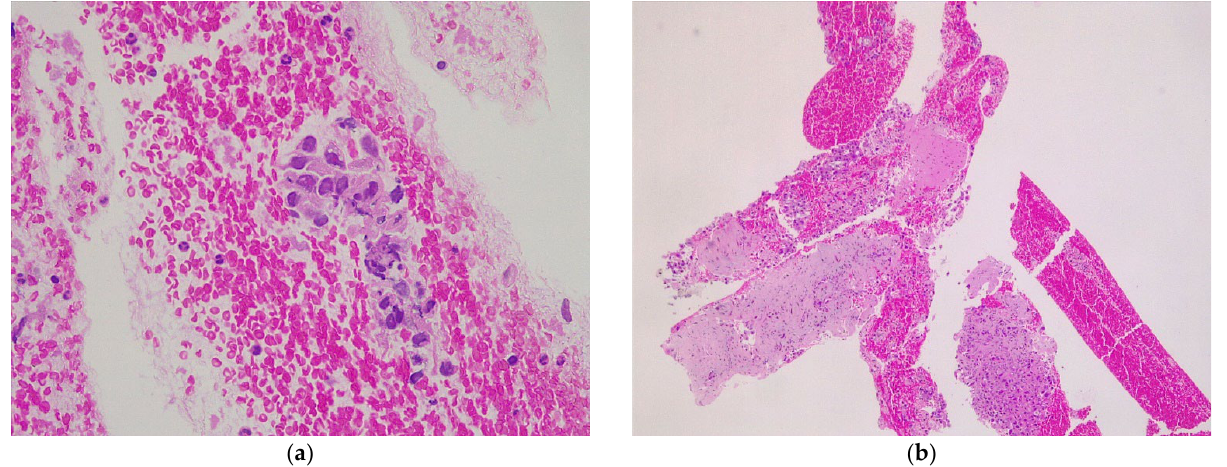
Figure 3. Microscopic aspects of endoscopic ultrasound specimen from a hepatic metastasis of pancreatic ductal adenocarcinoma (hematoxylin-eosin): ( a ) FNA specimen ( × 40) with free-floating pleomorphic glandular epithelium without stromal support and red blood cells; ( b ) FNB specimen ( × 5) with neoplastic glands infiltrating cores of liver parenchyma. Table 2. Sample adequacy in the EUS-FNB and EUS-FNA groups and comparisons between FNB and